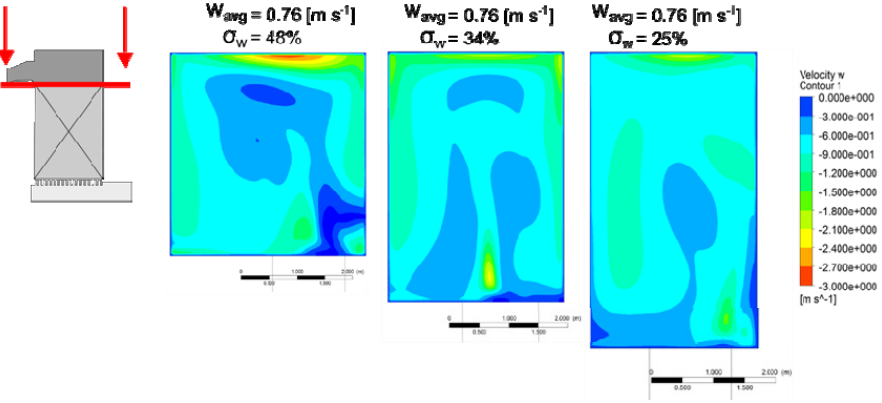
Figure 11. Homogeneity analysis of waste gas flow for different aspect ratios of the chamber. W avg [m·s − 1 ] is the average vertical velocity, while σ w is its relative standard